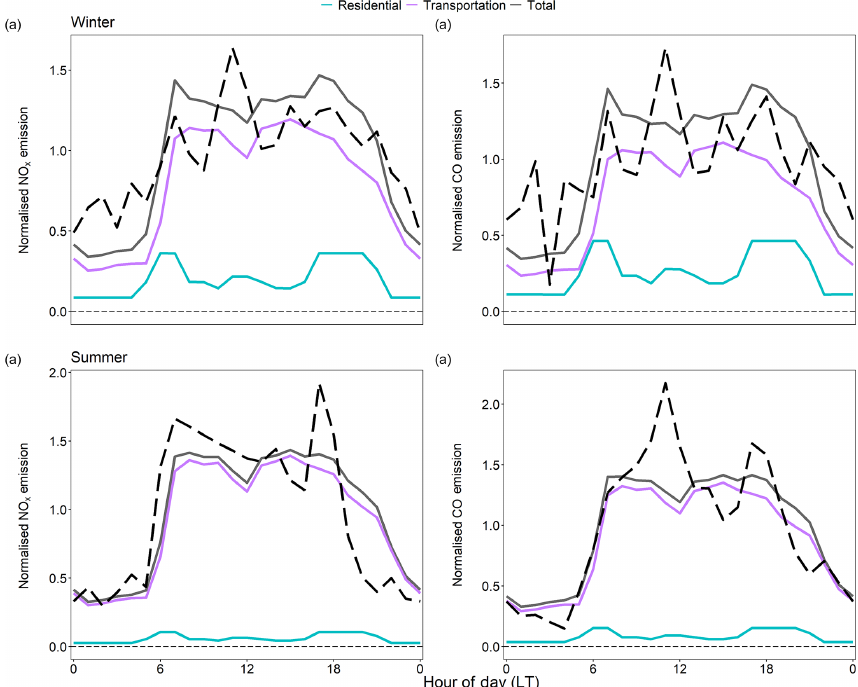
Figure 11. Comparison of normalised diurnal variation in NO x and CO emission predicted by the MEIC inventory and measured flux. The normalised emission has been calculated for the inventory by dividing hourly sector emission by the mean daily sector emission. Given there are no clear industrial or power generation emissions sources within the flux footprint, only the residential (blue solid line) and transportation (purple solid line) sectors have been presented. The normalised diurnal variation for these sectors has been multiplied by the normalised diurnal variation for the sum of the residential and transportation sectors (grey solid line) to reflect the relative contributions of the two sectors. Normalised diurnal variation in the measured emission has been calculated by dividing mean hourly emission by mean daily emission (black dashed line). Panels (a) and (b) show data for NO x and CO from the winter campaign and panels (c) and (d) for the